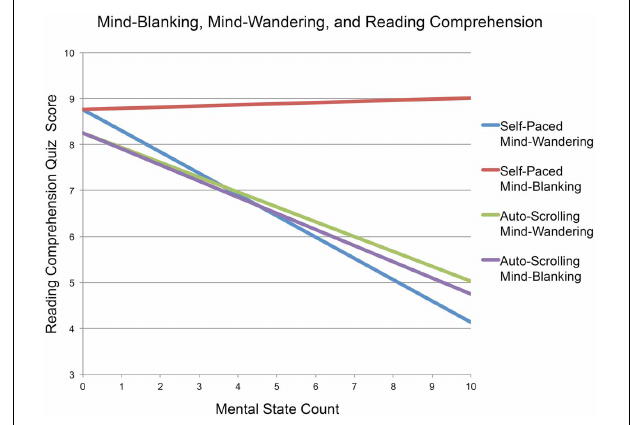
FIGURE 1 | Relationship between mind-blanking, mind-wandering, and reading comprehension, under both self-paced and auto-scrolling conditions in Experiment